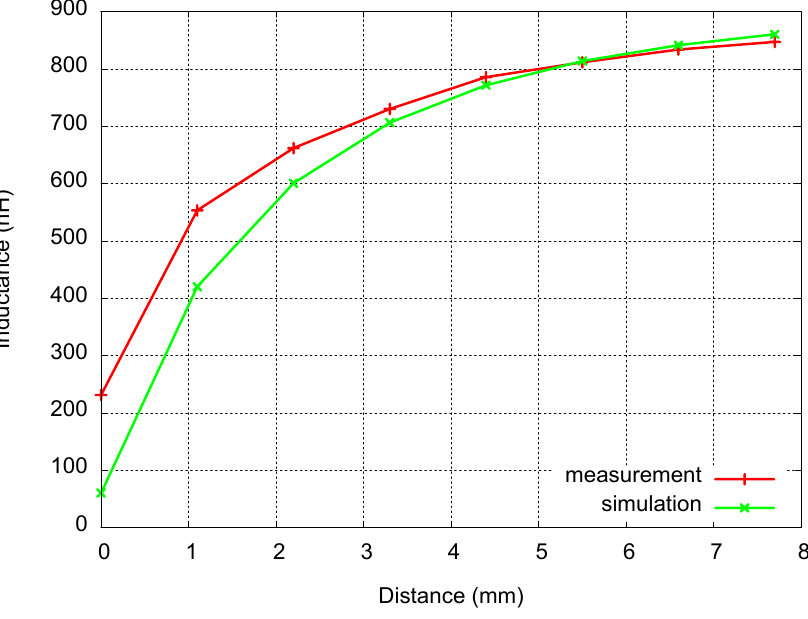
Figure 11. Inductance variation for small